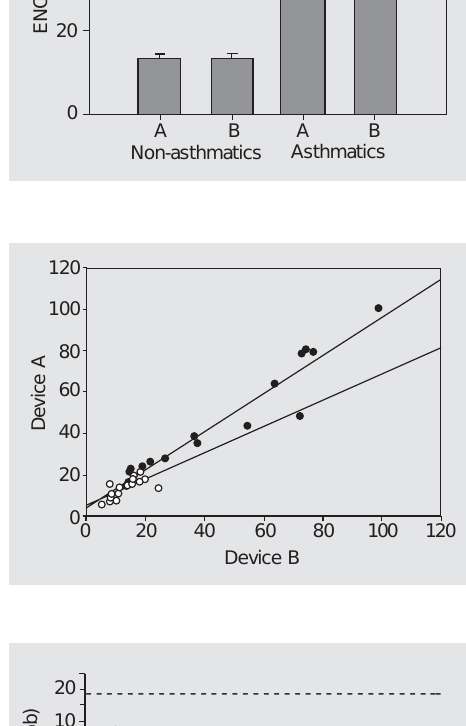
Figure 4. Bland-Altman diagram comparing exhaled nitric oxide (ENO) measured with the Sievers mouthpiece (A) and the mouthpiece containing a HEPA filter (B) in asthmatic patients (top) and non-asthmatic subjects (bottom). The mean difference was 0.49 ppb and the limits of agreement were 18.74 and -17.75 for ENO from asthmatic patients. These limits are ac- ceptable and pertain to the 2 SD range of B-A analyses.